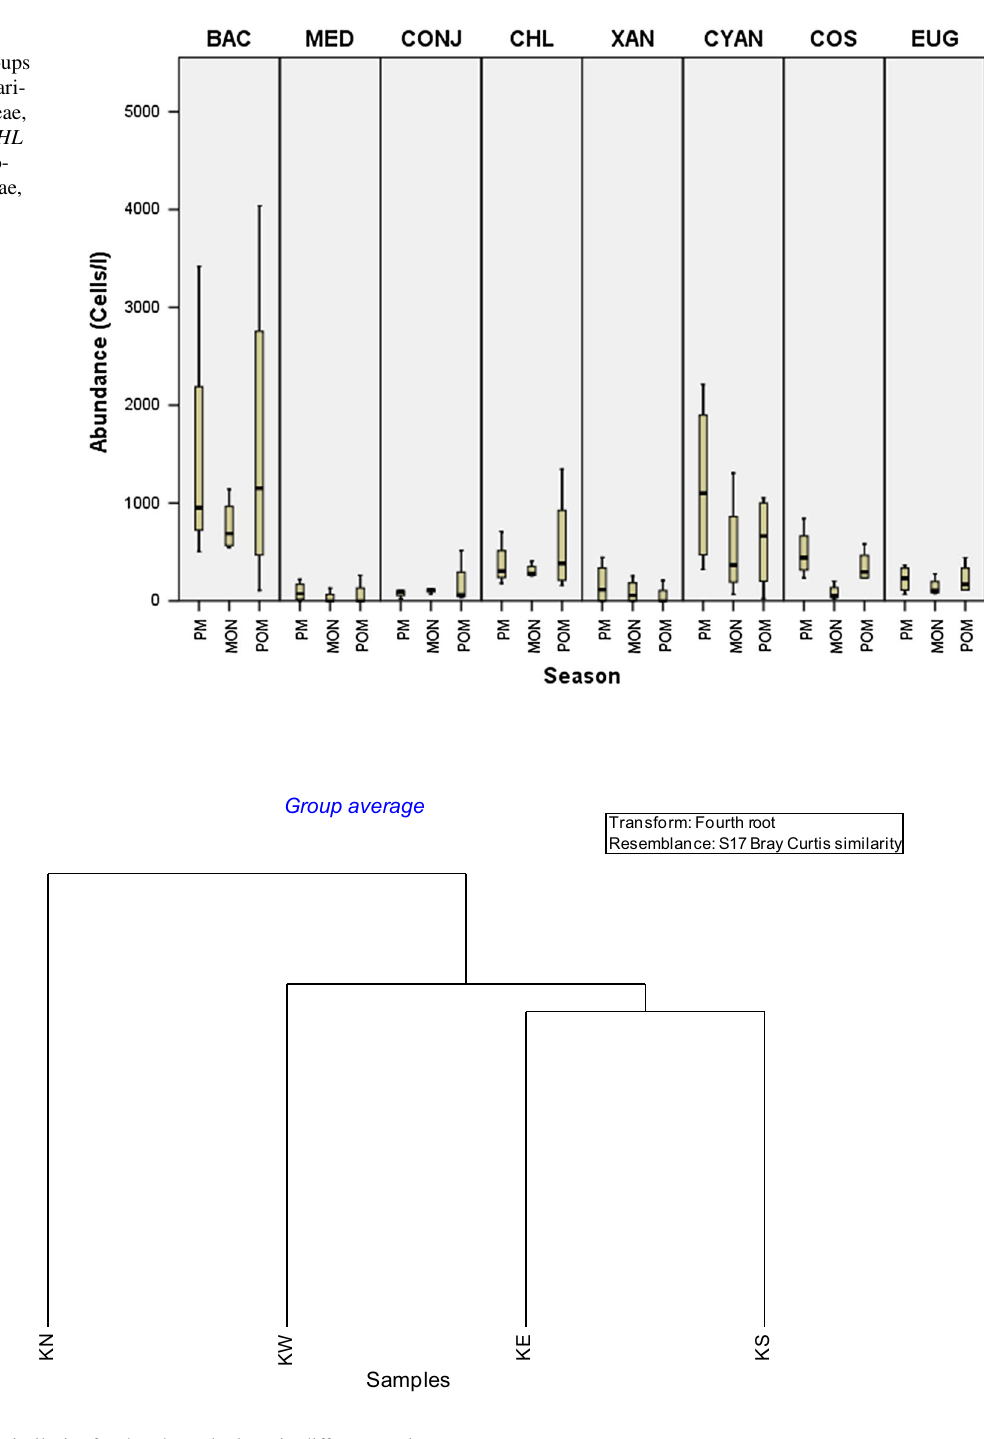
Fig. 4 Dendrogram showing similarity for the phytoplankton in different